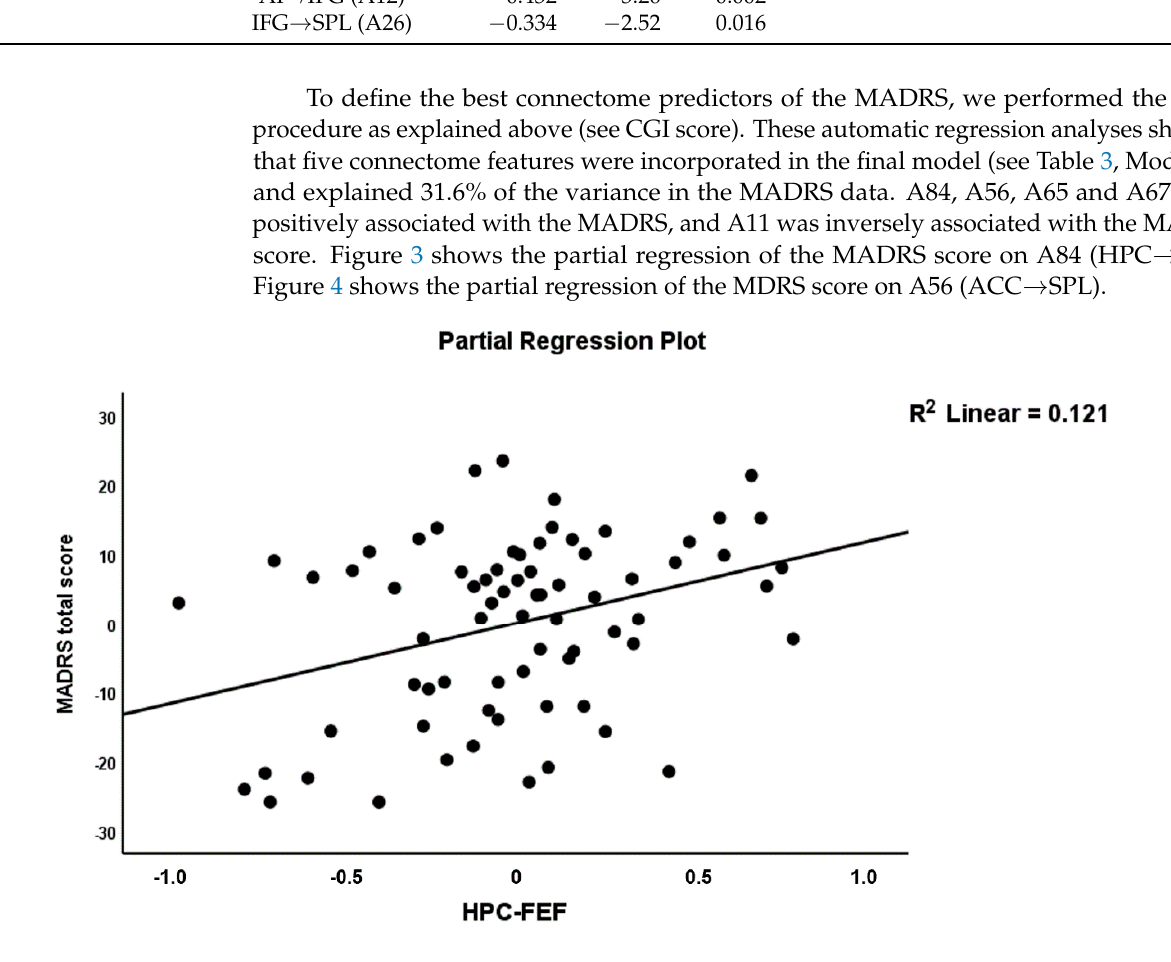
Figure 3. Partial regression plot of the MADRS score on the HPC → FEF connection.